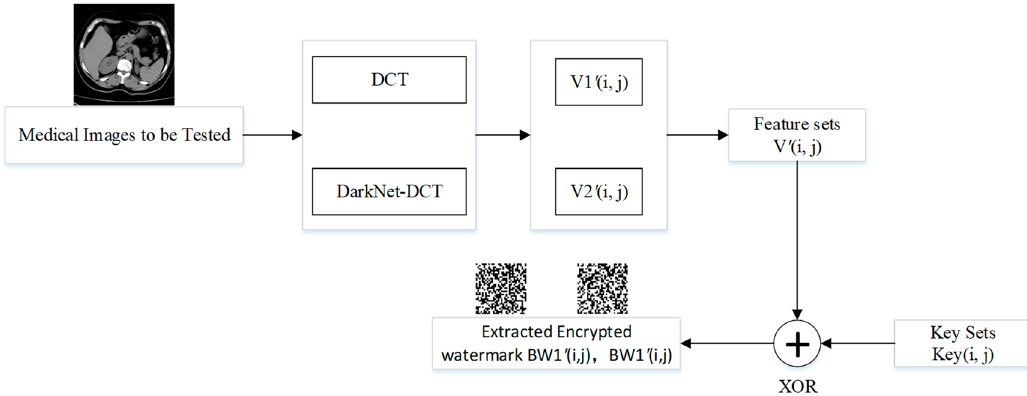
Figure 9. Flowchart of watermark extraction .